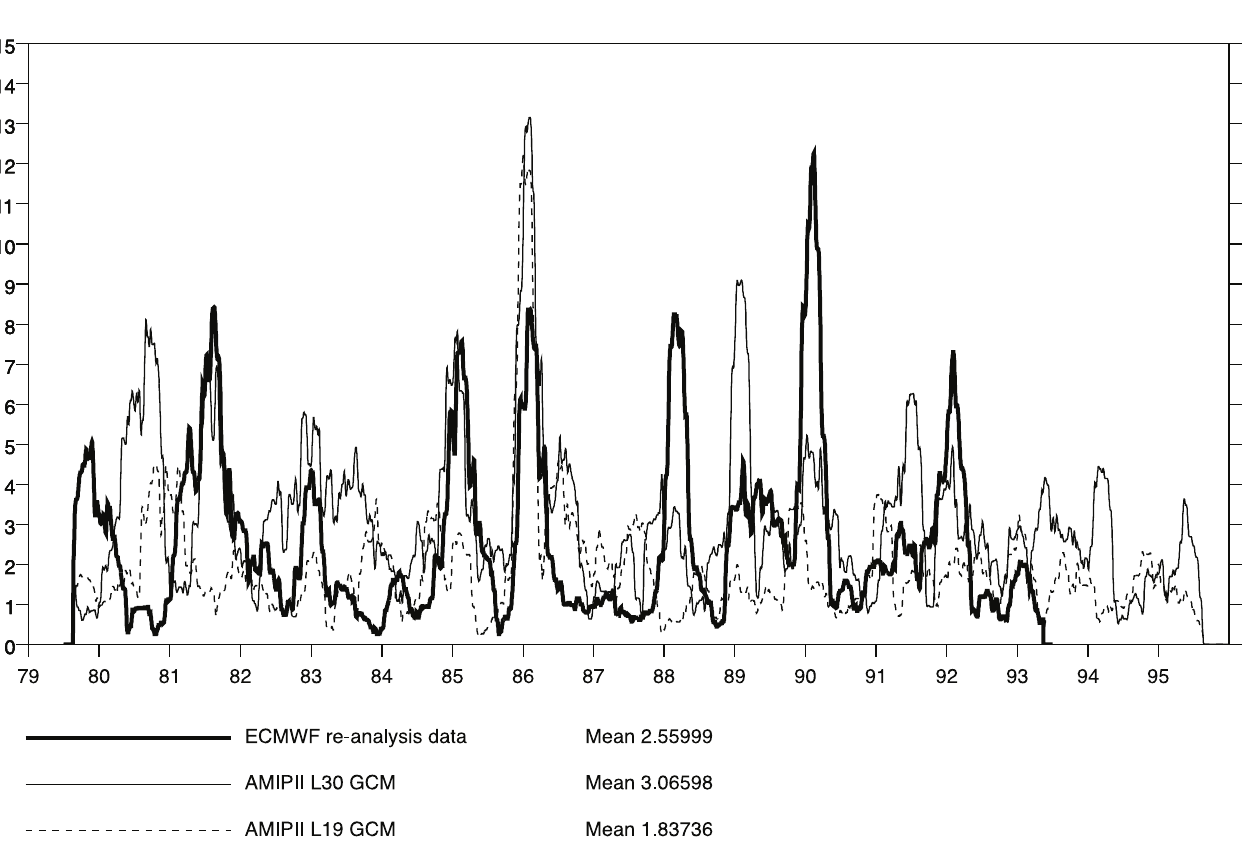
Fig. 6. Time-series of an index of MJO activity based on the 20-100 day filtered variance of 200 hPa zonal wind in the Tropics. Bold line - ECMWF re-analysis data; thin solid line - L30 GCM AMIPII integration; dotted line - L19 GCM AMIPII integration. From Inness et al.